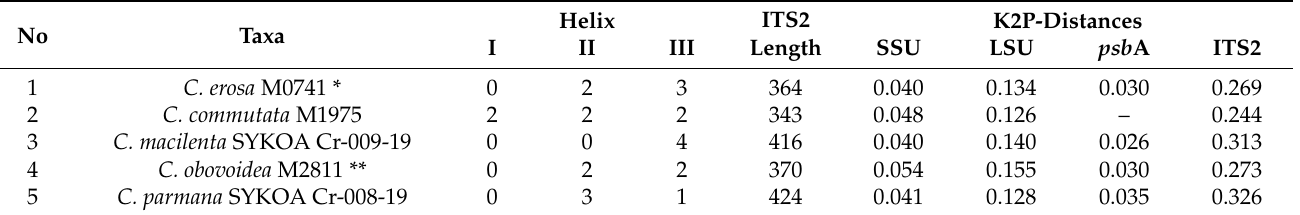
Table 1. Number of CBCs in ITS2, length and K2P-distances between C. tropica strain Vp 376 and reference strains of C. erosa , C. commutata , C. macilenta, C. obovoidea and C. parmana